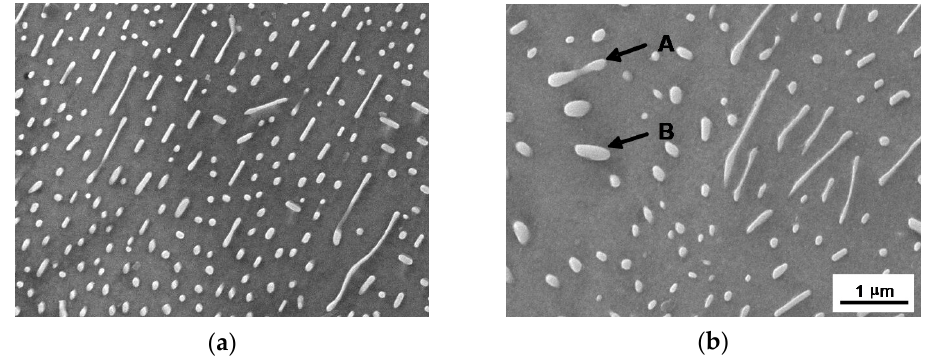
Figure 9. Cementite edge spheroidization before break-up into globular units ( a ), and detail of the edge spheroidization phenomenon depending on the cementite lamellae aspect ratio ( b ), after the intermediate annealing treatment in the coarse pearlite microstructure.